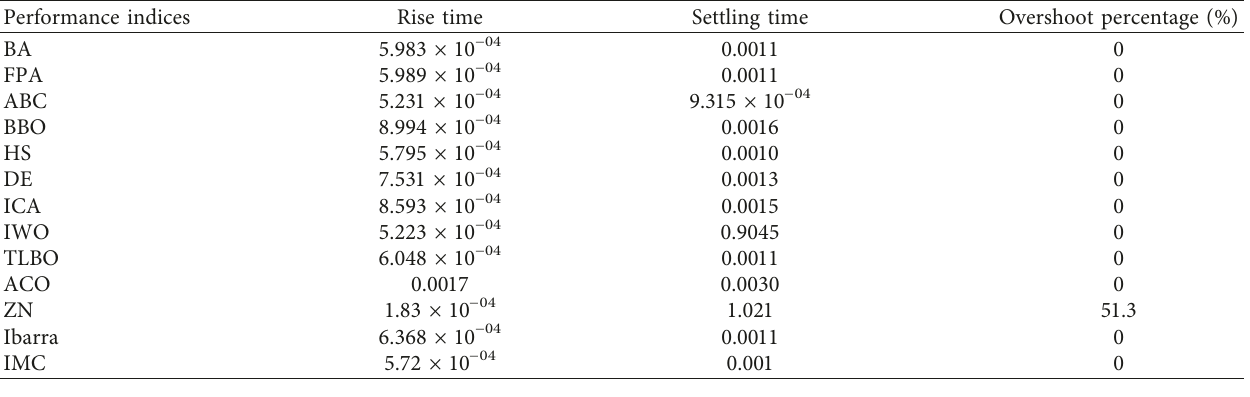
Table 2: Time-domain performance